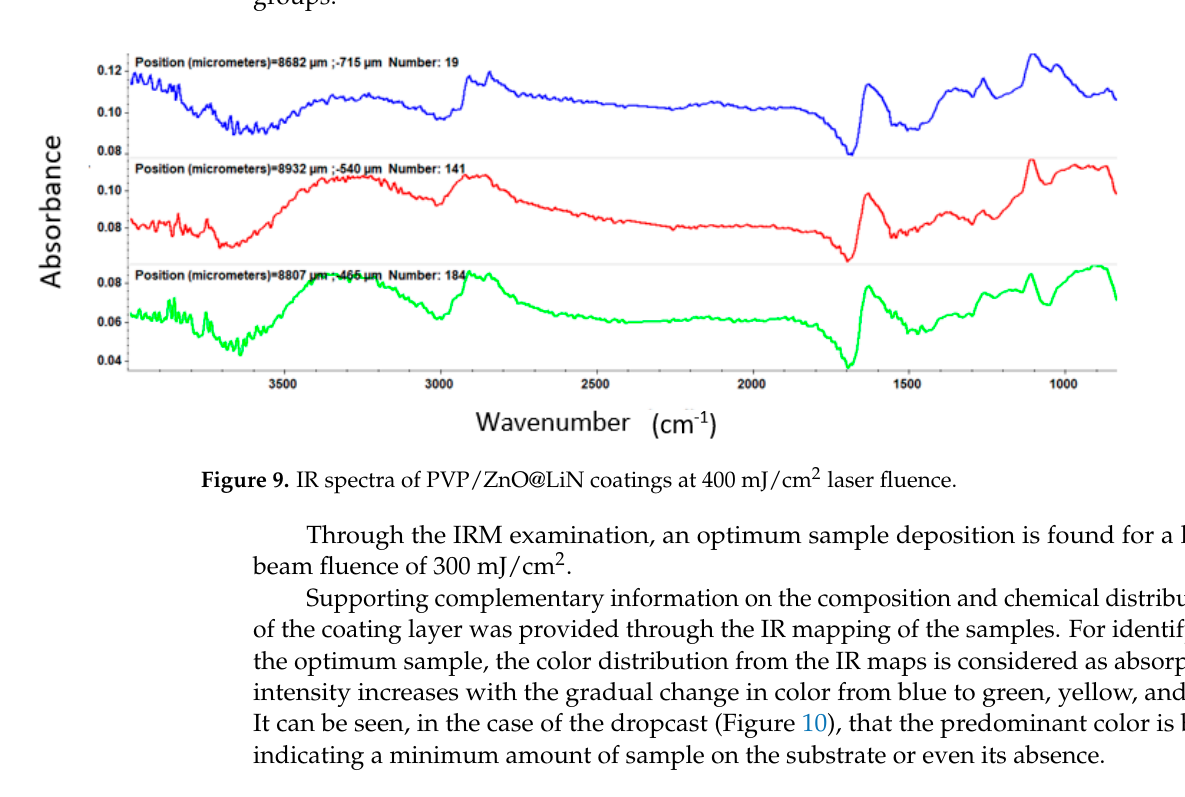
Figure 8. IR spectra of PVP/ZnO@LiN coatings at 300 mJ/cm 2 laser fluence.